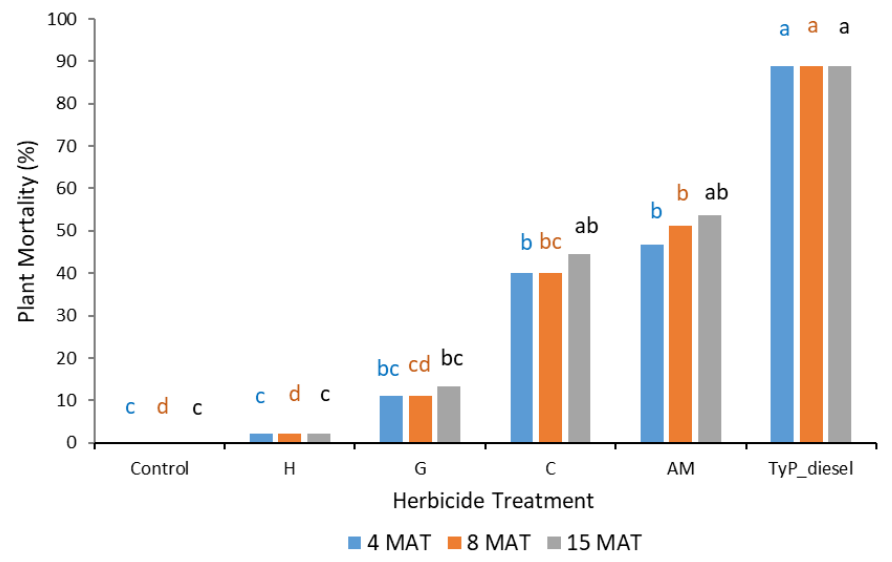
Figure 9. Plant mortality of mimosa bush 3, 8 and 15 MAT following cut stump herbicide application in trial 3. H, hexazinone; G, glyphosate; C, clopyralid; AM, aminopyralid + metsulfuron-methyl; TyP_diesel, triclopyr + picloram mixed with diesel. For each monitoring time, columns with different letters indicate significant difference by Tukey’s test with 95% confidence.